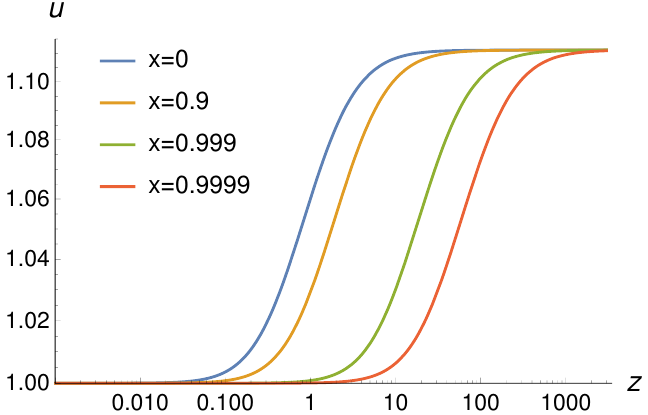
Figure 1: Zero temperature solutions: plot of the metric function u ( z ) for several values of x . As x → 1 the domain wall moves towards the IR ( z → ∞